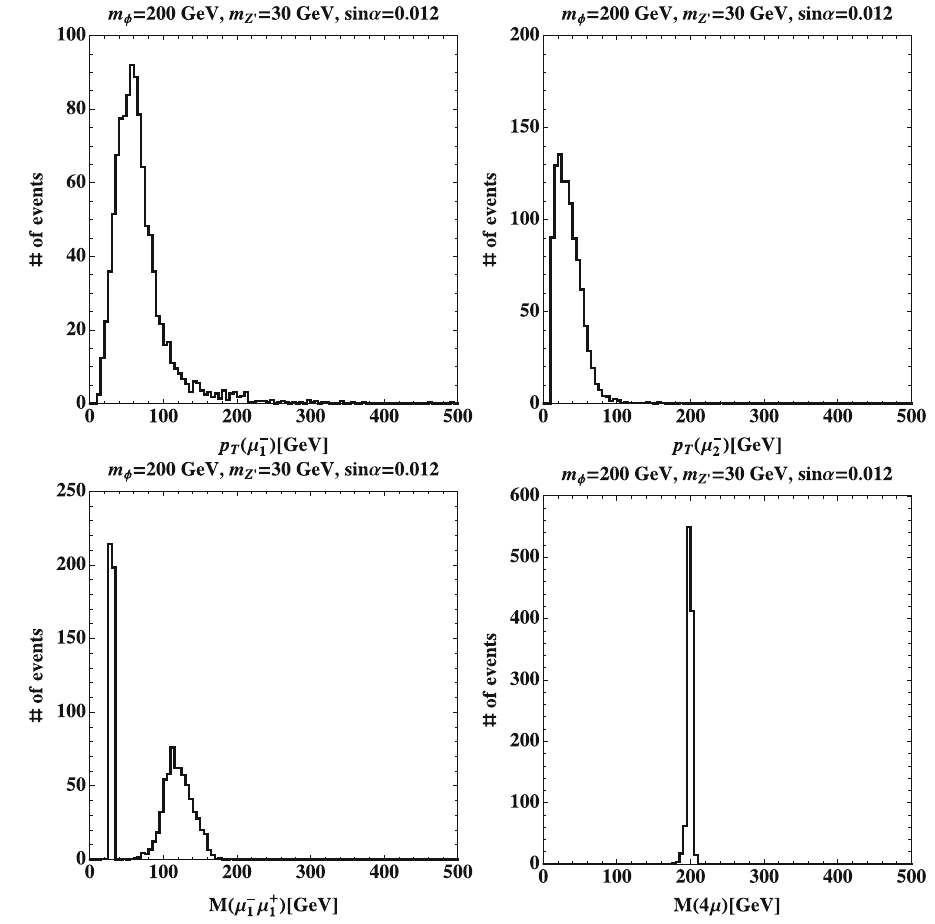
Fig. 6 Kinetic distributions of final state muons for